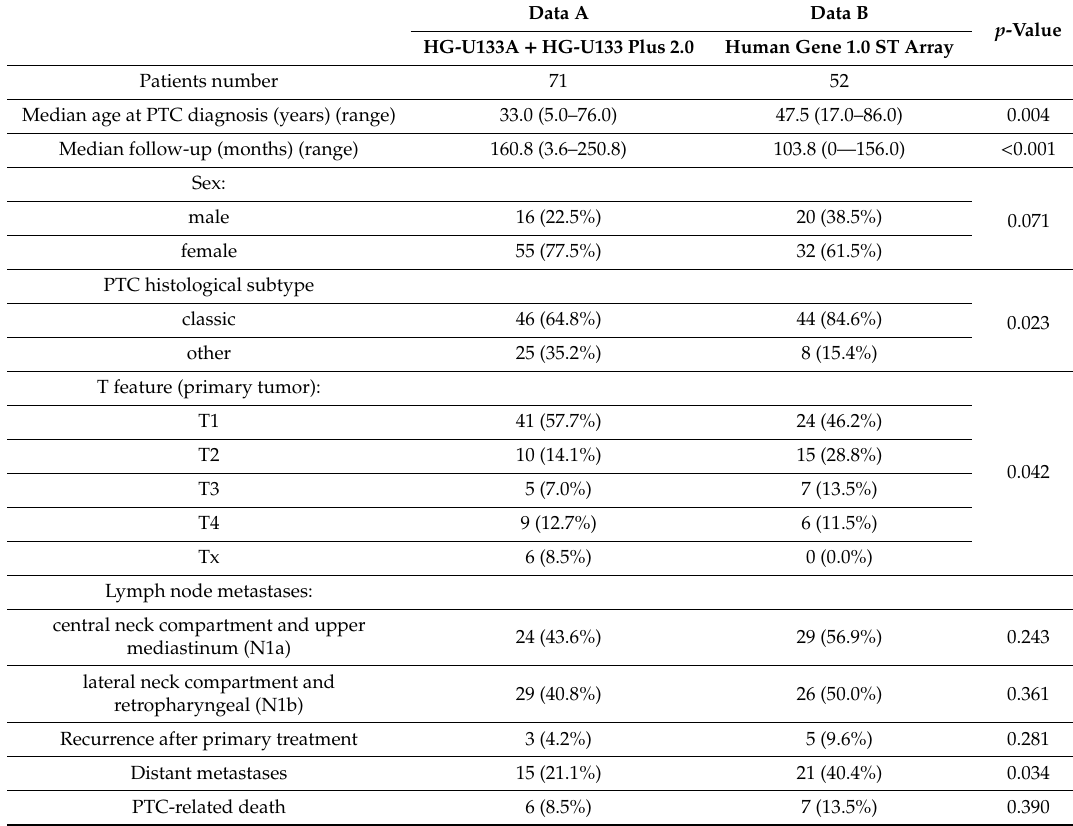
Table 6. Clinical characteristic of the whole group with considering microarray platform used.